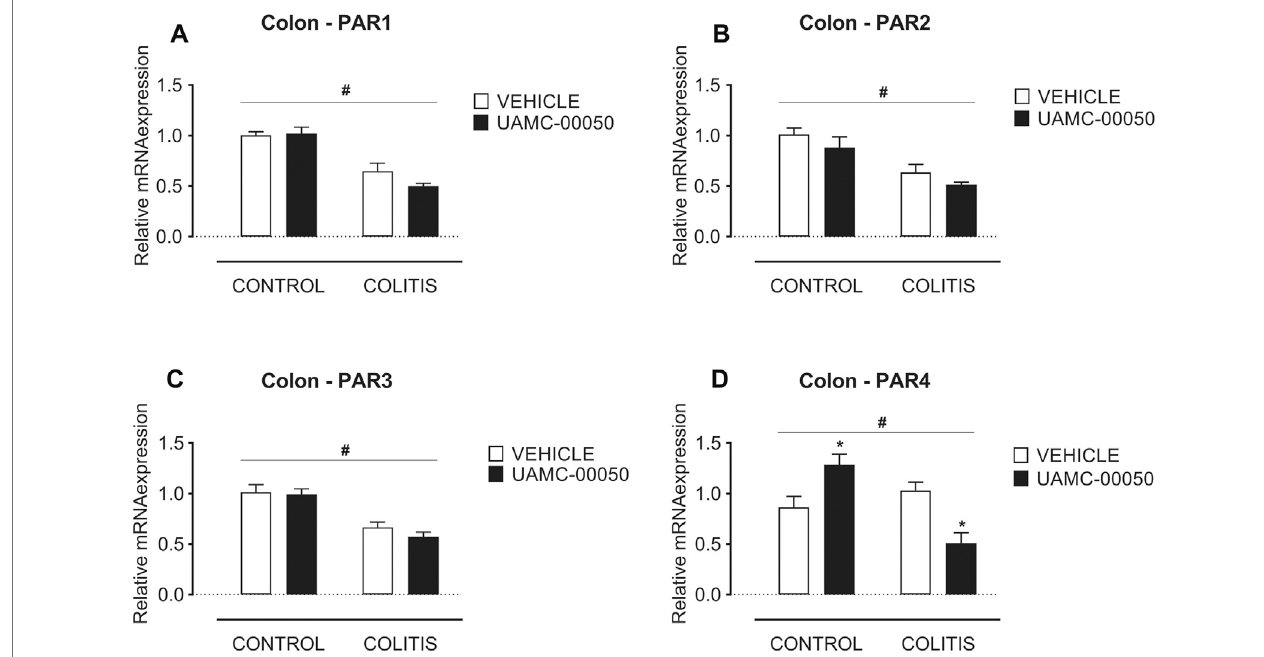
FIGURE 5 | Effect of curative treatment with UAMC-00050 on colonic mRNA expression of protease-activated receptors. Effect on expression of PAR1 (A) , PAR2 (B) , PAR3 (C) and PAR4 (D) , signi fi cant effect of factor “ colitis ” and signi fi cant interaction between factor “ colitis ” and “ treatment ” . Data are determined post- mortem at week 4(after a 2-week treatmentwithUAMC-00050). Dataare represented as mean ± SEM. Two-way ANOVA followed by One-way ANOVA and LSD post- hoc test when appropriate. # p < 0.05; signi fi cant effect of colitis, * p < 0.05; signi fi cant effect of treatment, n (cid:2) 7 – 8/group.